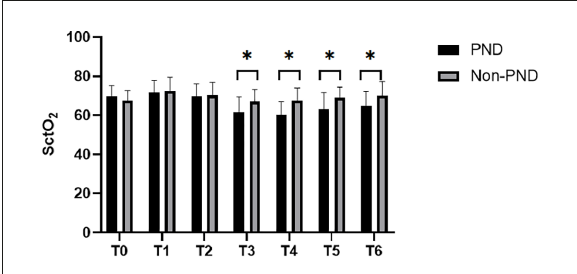
FIGURE3 Comparison of SctO 2 at different time points between group PND and group non-PND. ∗ p < 0.05.